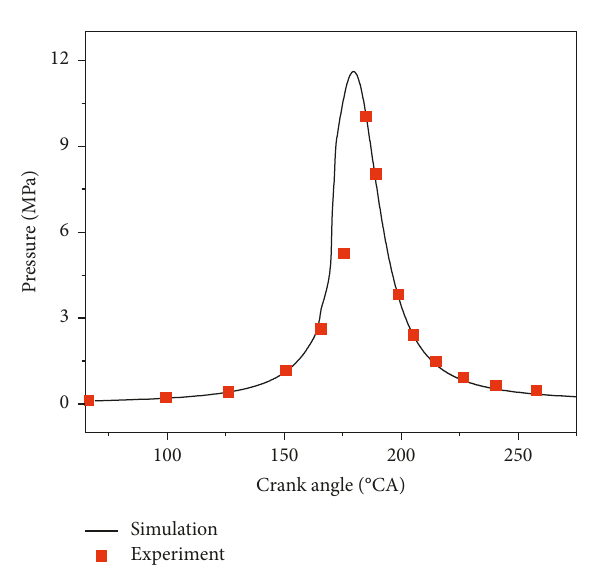
Figure 4: The simulation and experiment pressure curves. Table 1: The in-cylinder distribution of C4H9OH